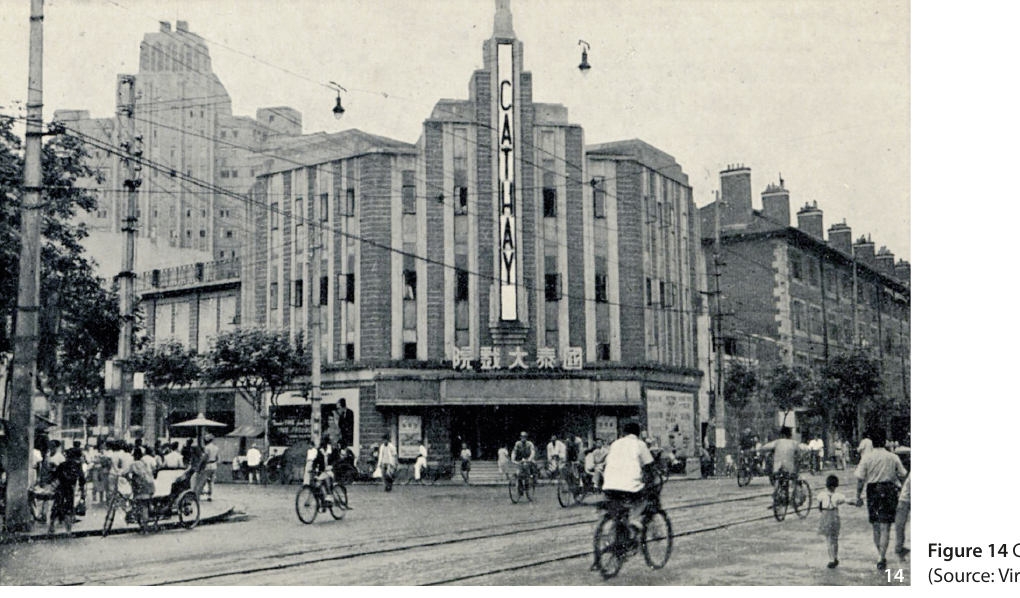
Figure 14 Cathay Theatre, 1949 14 (Source: Virtual